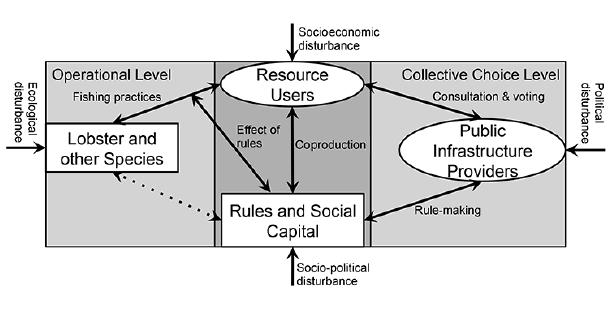
Fig. 1 . The social-ecological system, as conceptualized by Anderies et al.